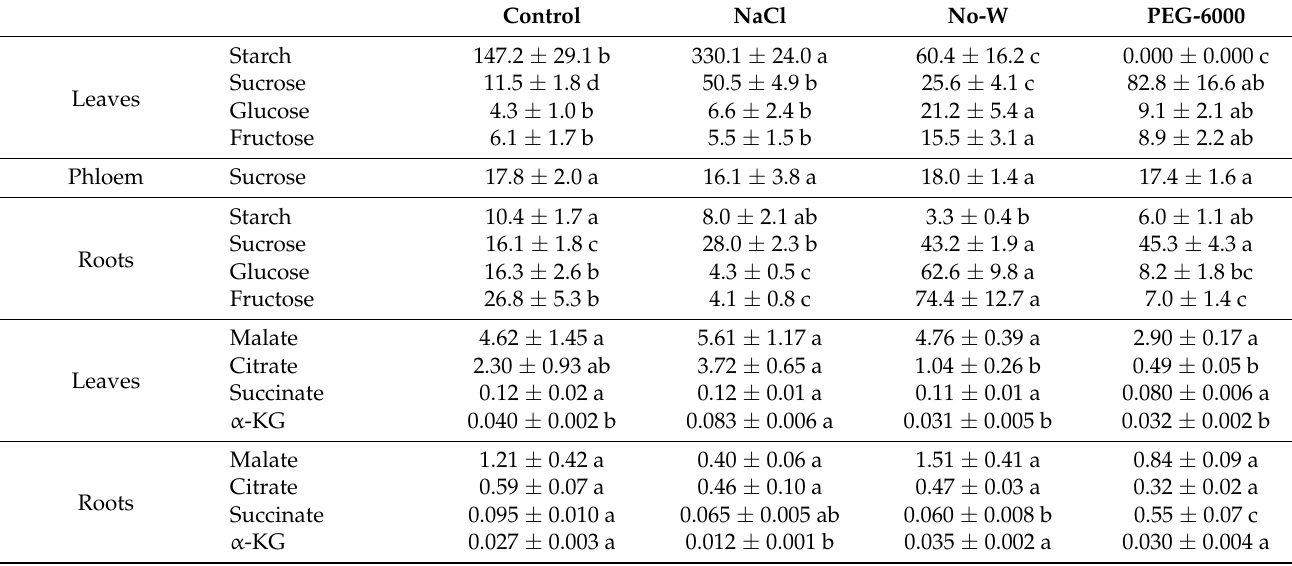
Table 2. Effect of the different water-stress treatments on the carbohydrate